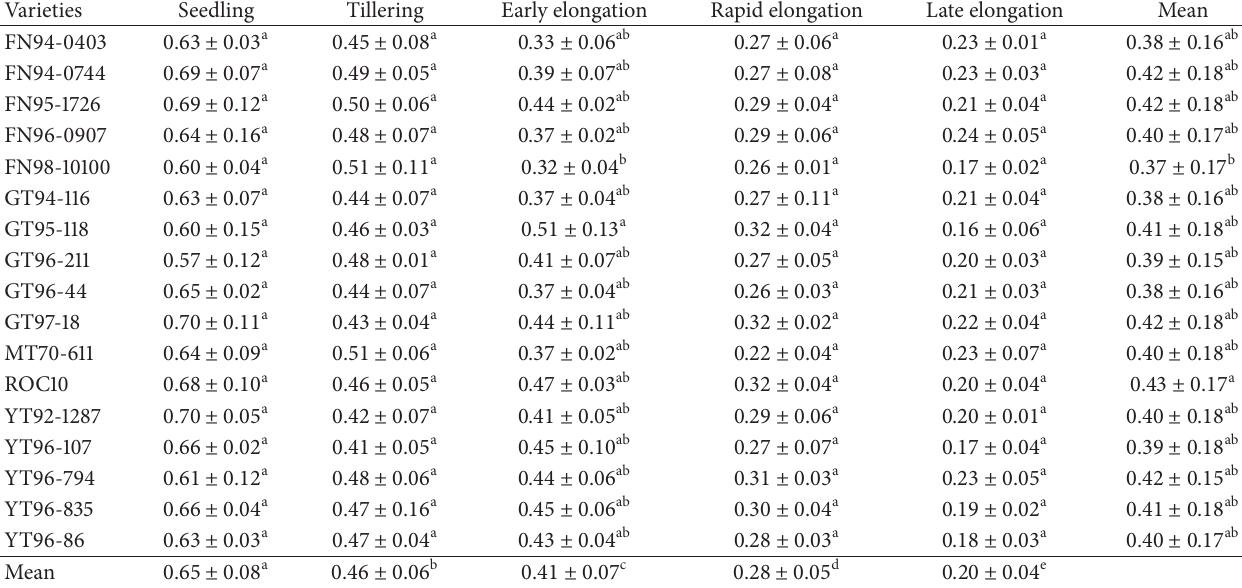
Table 3: Seasonal changes of transmission coefficient for diffuse radiation in sugarcane varieties.